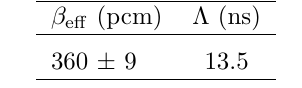
Table 18. Flattop-23 benchmark model kinetics parameters.